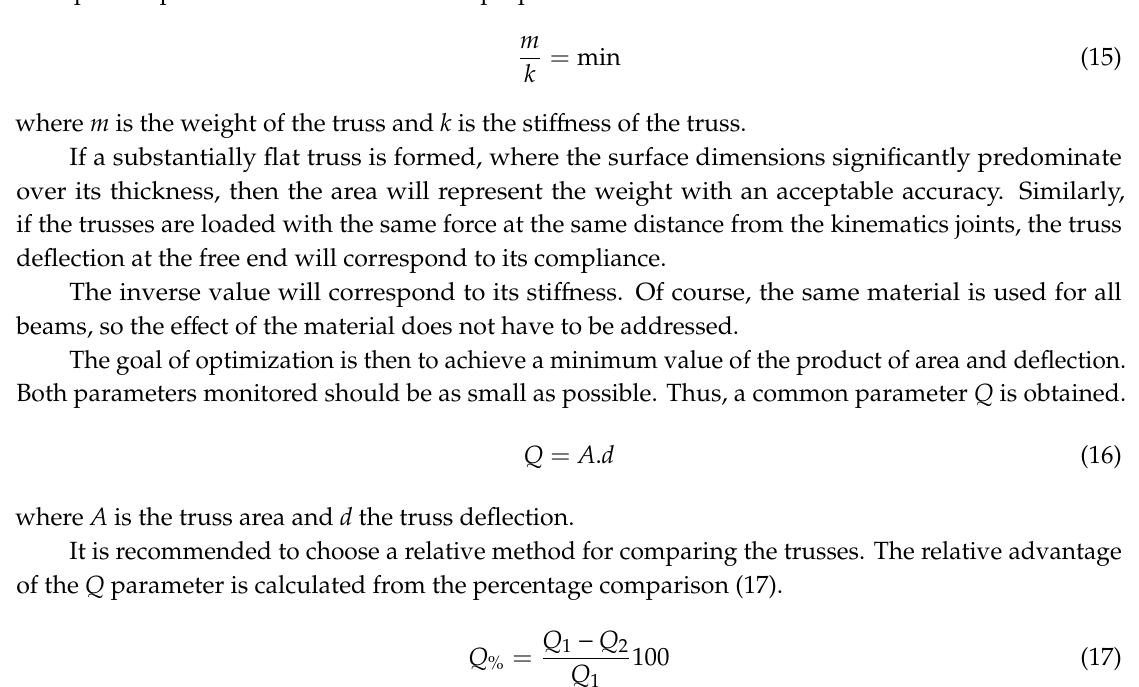
Figure 9. Direction of the principal compressive stresses in the basic beam. A slender beam with distributed stress C is obtained through the inverse shape of the beam of uniform stress (beam C, Figure 10). The advantage of this beam is that the maximum stress is distributed along the entire length of the beam, which reduces its weight. A disadvantage is that, at the same time, the stiffness of the beam is significantly reduced. Figure 10. Direction of the principal compressive stresses of a parabolically formed beam (beam C) with distributed stress. The simplest version of the Michell truss has only two arms. The arms are in the shape of the logarithmic spirals (truss D, Figure 11). The addition of inner members optimizes the resulting weight